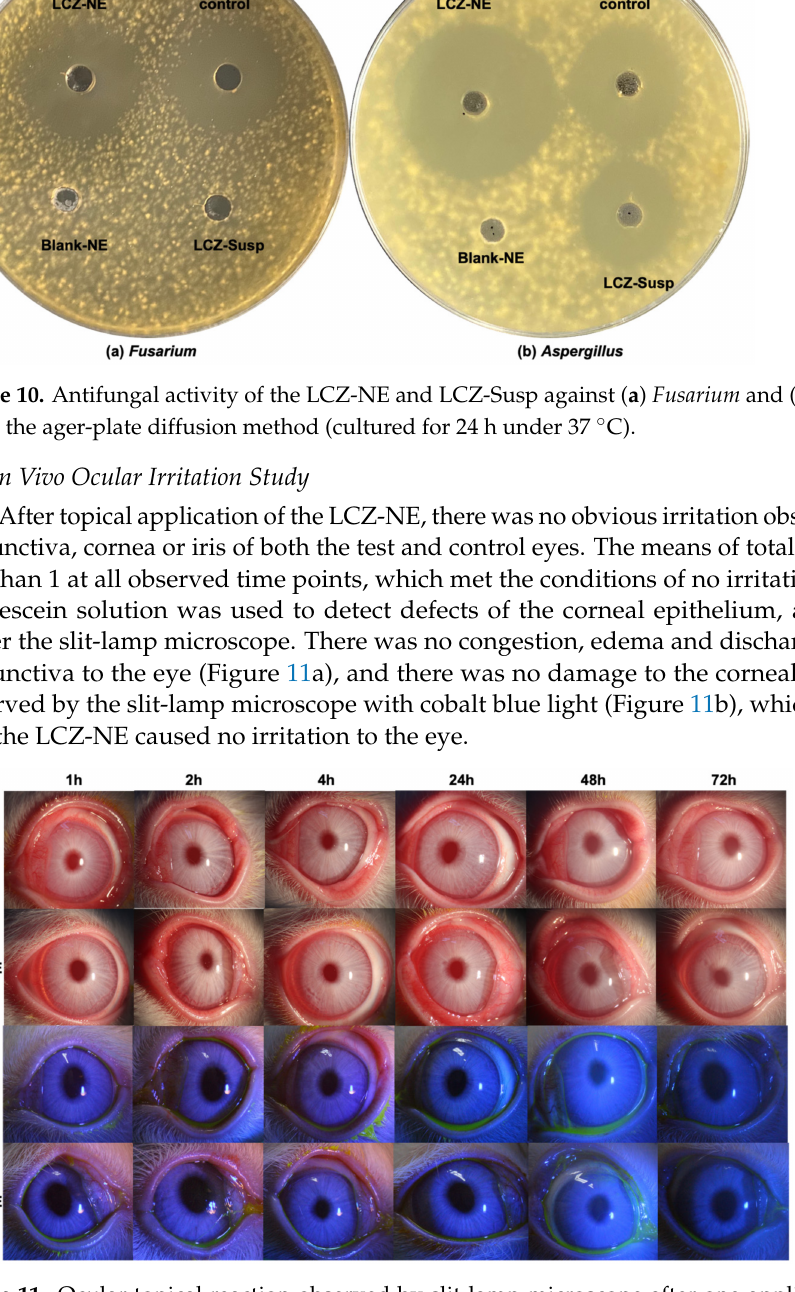
Figure 11. Ocular topical reaction observed by slit-lamp microscope after one application of the LCZ-NE and saline (as control) to rabbits. ( a ) Pictures with visible light and ( b ) cobalt blue light, post-fluorescein-sodium dropped into rabbit